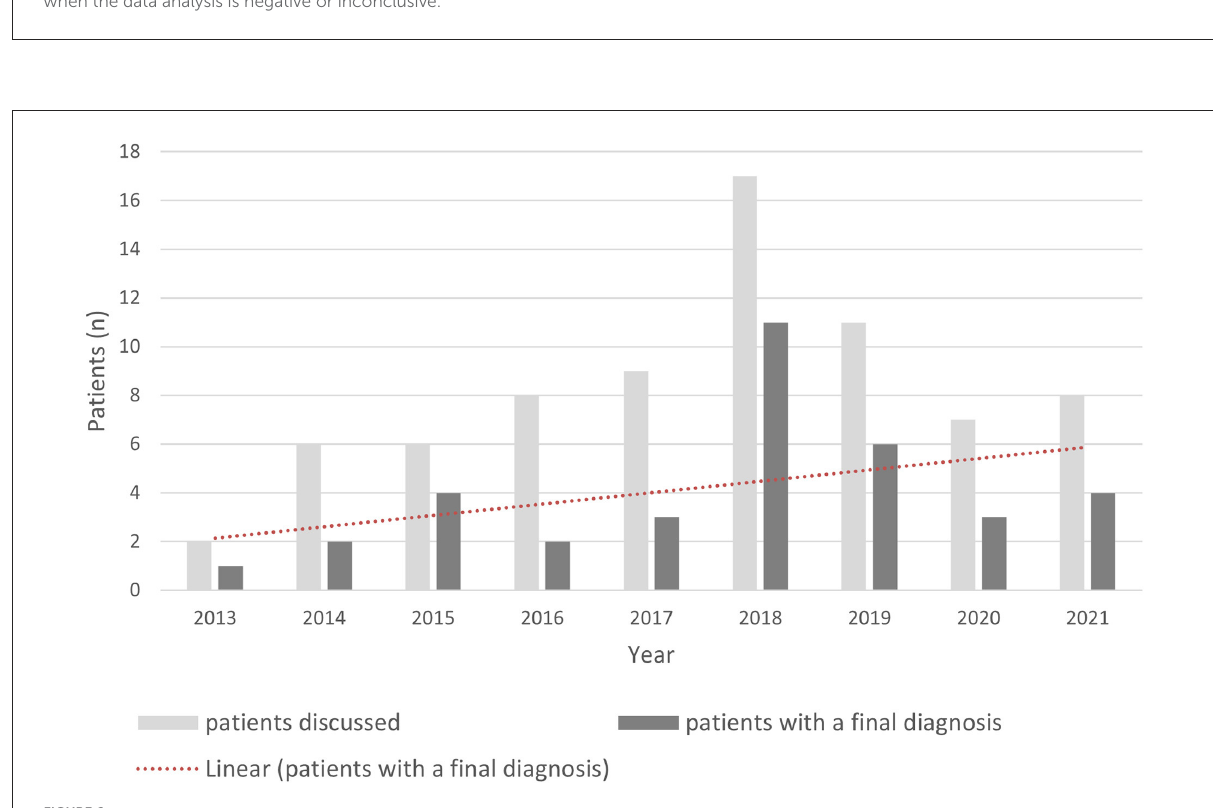
FIGURE6 Rate of diagnosis according to the year of presentation at the WM